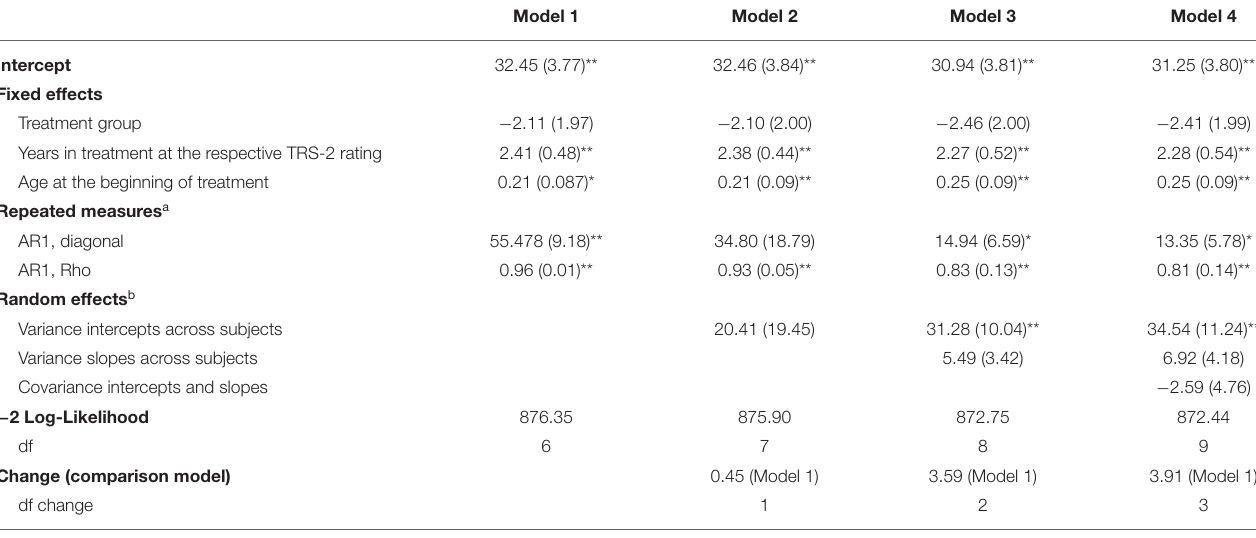
TABLE 5 | Estimates of multilevel linear analysis of the TRS-2 total scores based on treatment group, years in treatment and age at the beginning of